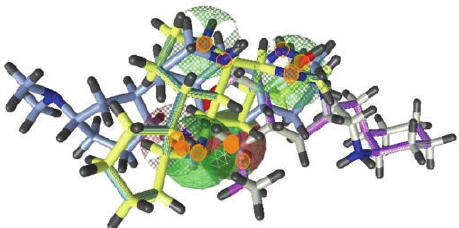
Figure 6: Superimposition of Pharmacophore and best hit com- pounds. Yellow coloured sticks represents shared common struc- tural features, small Orange coloured spheres represents similar bond order and green spheres represents hydrogen bond